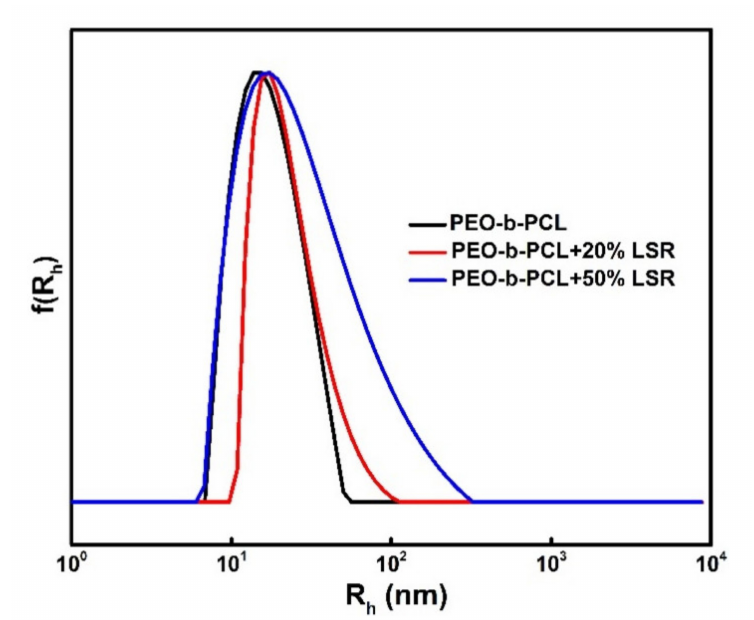
Figure 2. Comparison of the size distributions from Contin analysis for the PEO-b-PCL micelles, PEO-b-PCL + 20%LSR, and PEO-b-PCL + 50%LSR nanocarriers at 90 ◦ in aqueous solutions using the organic solvent evaporation method.